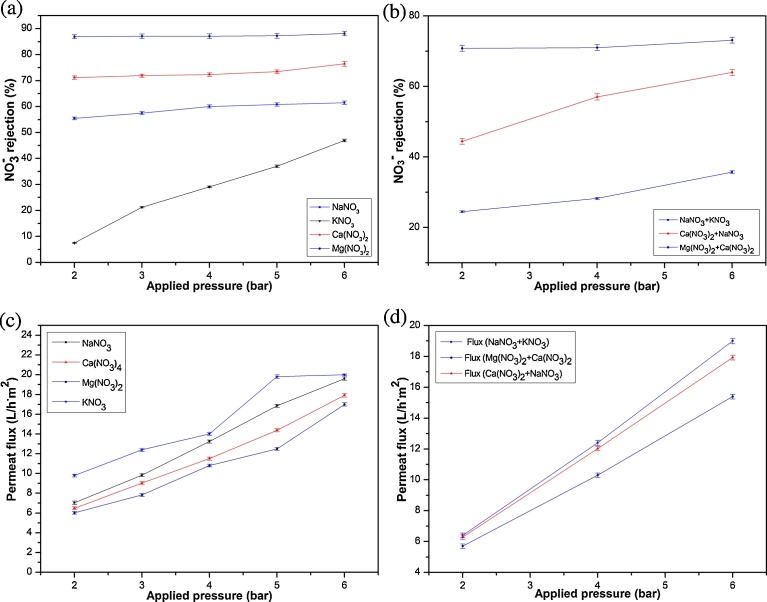
The effect of pressure on permeate flux and NO3− retention for binary solutions KNO3, NaNO3, Ca(NO3)2, Mg(NO3)2 (a and c) and ternary solutions (NaNO3 + KNO3), (NaNO3 + Ca(NO3)2),(Ca (NO3)2 + Mg(NO3)2) (b and d) (Ci = 50 mg(NO3−)/L and natural pH).